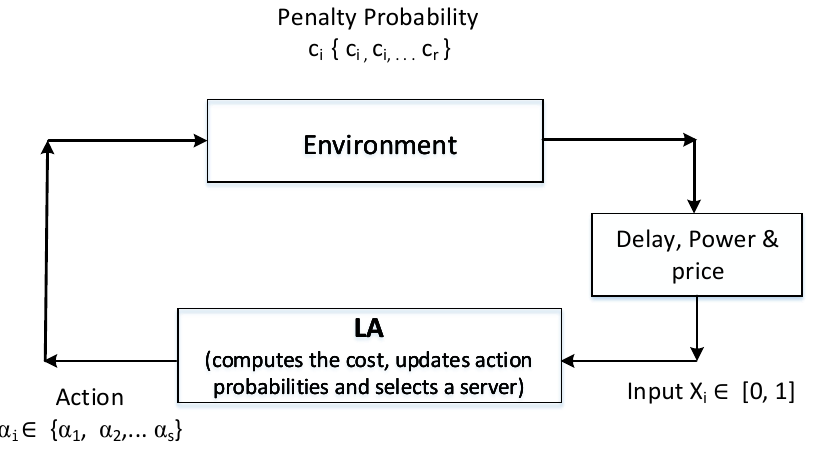
Figure 1. Stochastic learning